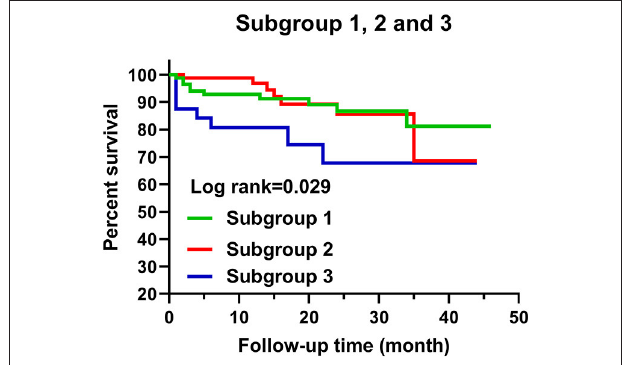
FIGURE 3 | Kaplan–Meier curves for the classification of three subgroups and MACE.